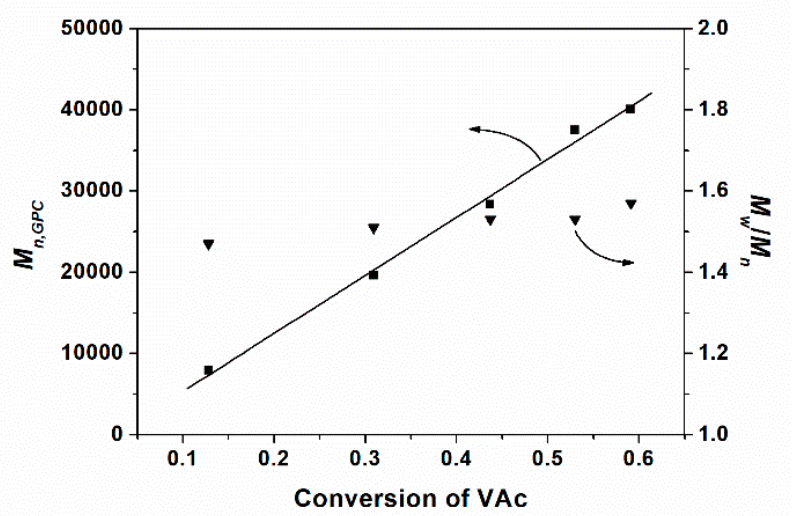
Figure 3. Molar mass and dispersity of the copolymer as a function of VAc conversion.